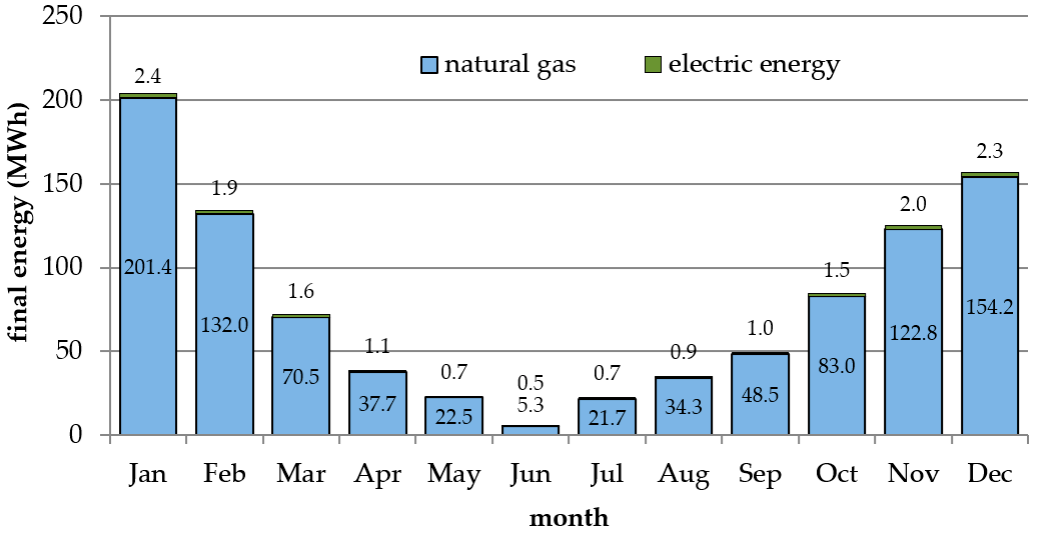
Figure 3. Monthly sums of final energy demand used for heating and auxiliary electricity; fuel—natural gas (scenario 2).